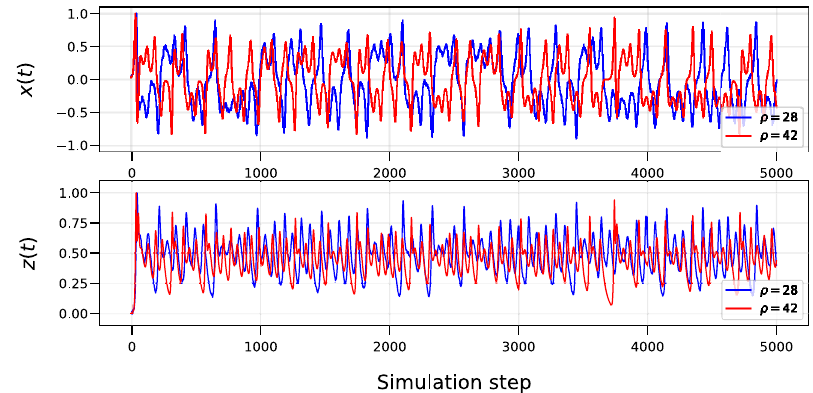
Figure 2: Time traces of the two Lorenz systems with noise, where 𝜎 = 10, 𝛽 = 8 ∕ 3 and with different 𝜌 (for the x -coordinate, top figure, and for the z -coordinate, bottom